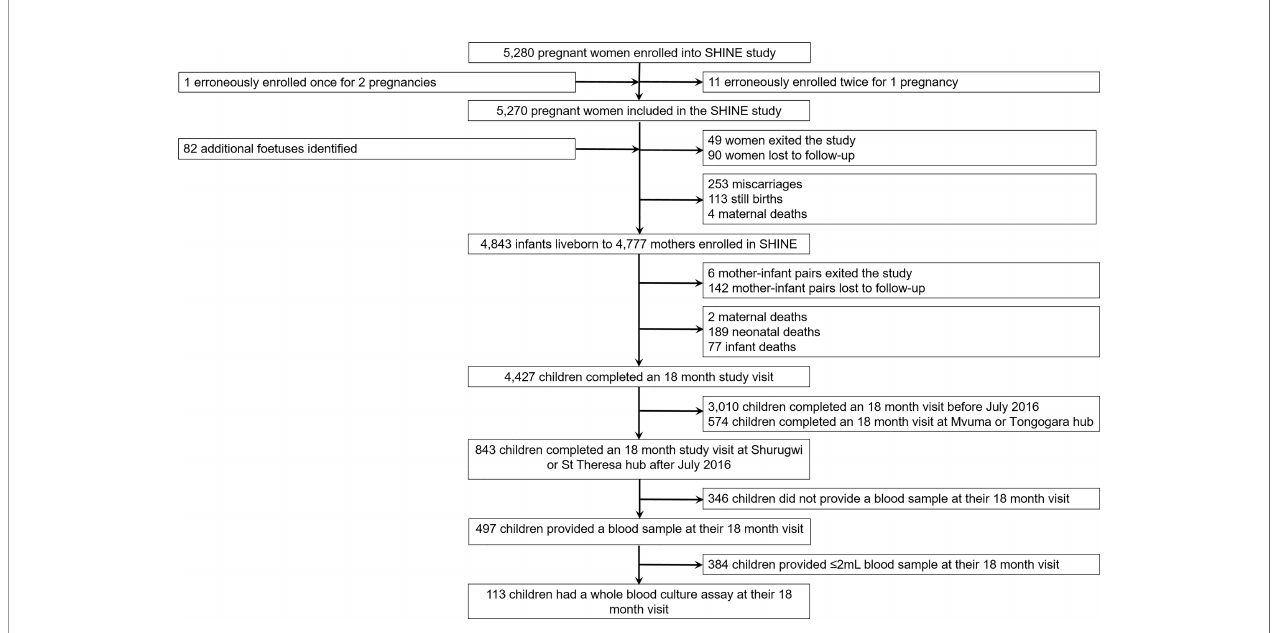
FIGURE 1 | Selection of 18-month-old infants for inclusion in the immune function sub-study of